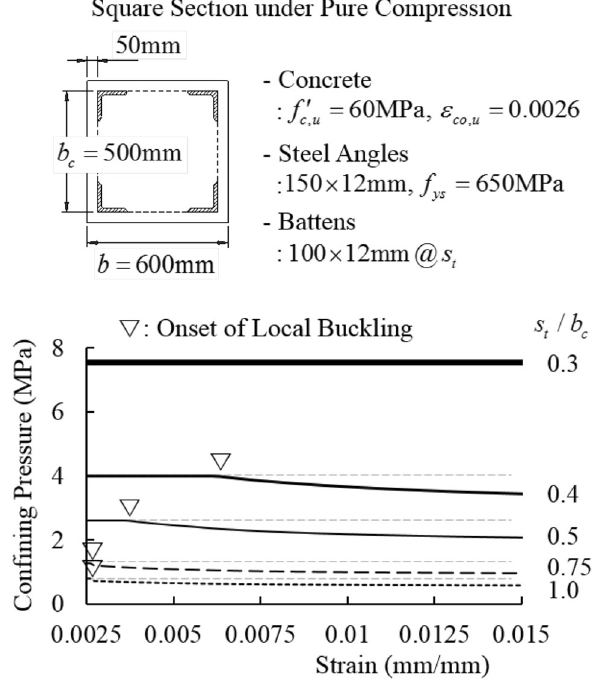
Fig. 7 Reduction of confining pressure after local buckling of steel